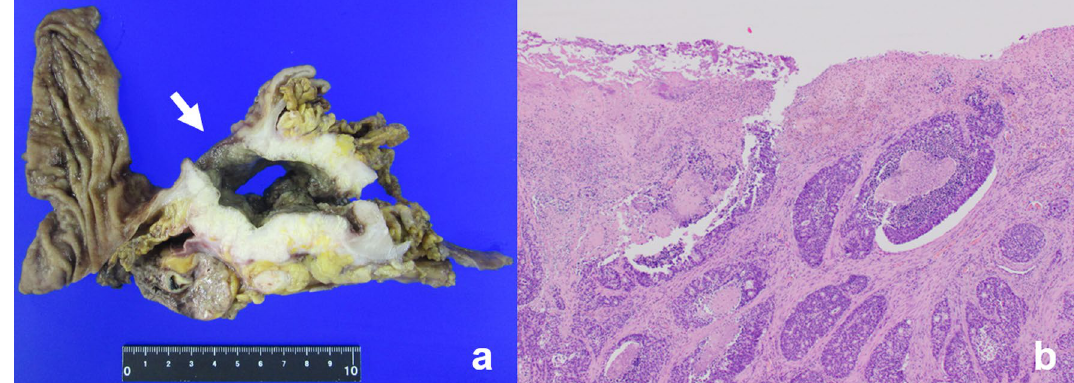
Fig. 5 a The white arrow indicates the gastrocolic fistula that surrounded the tumor. b The surface of the fistula was covered with tumor